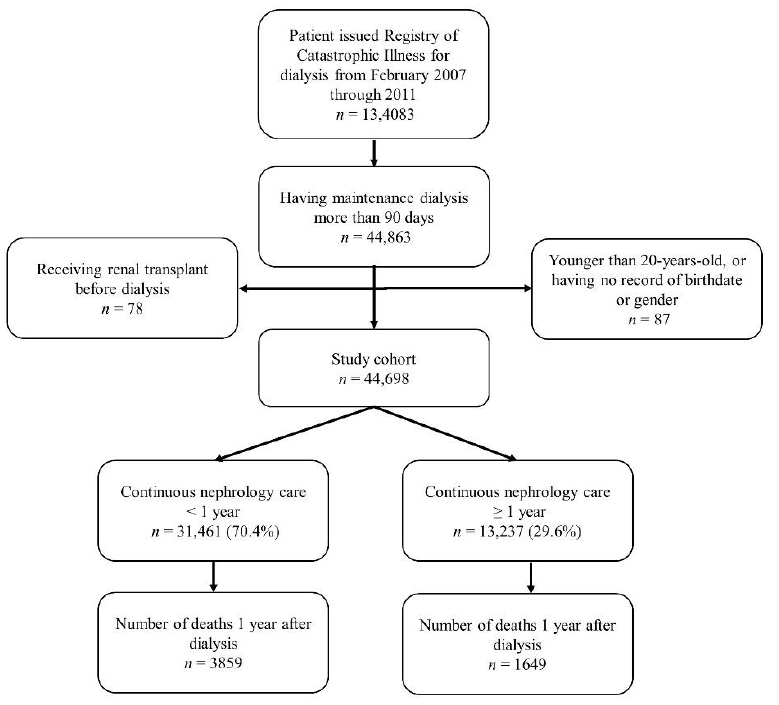
Figure 1. Study design flow chart.